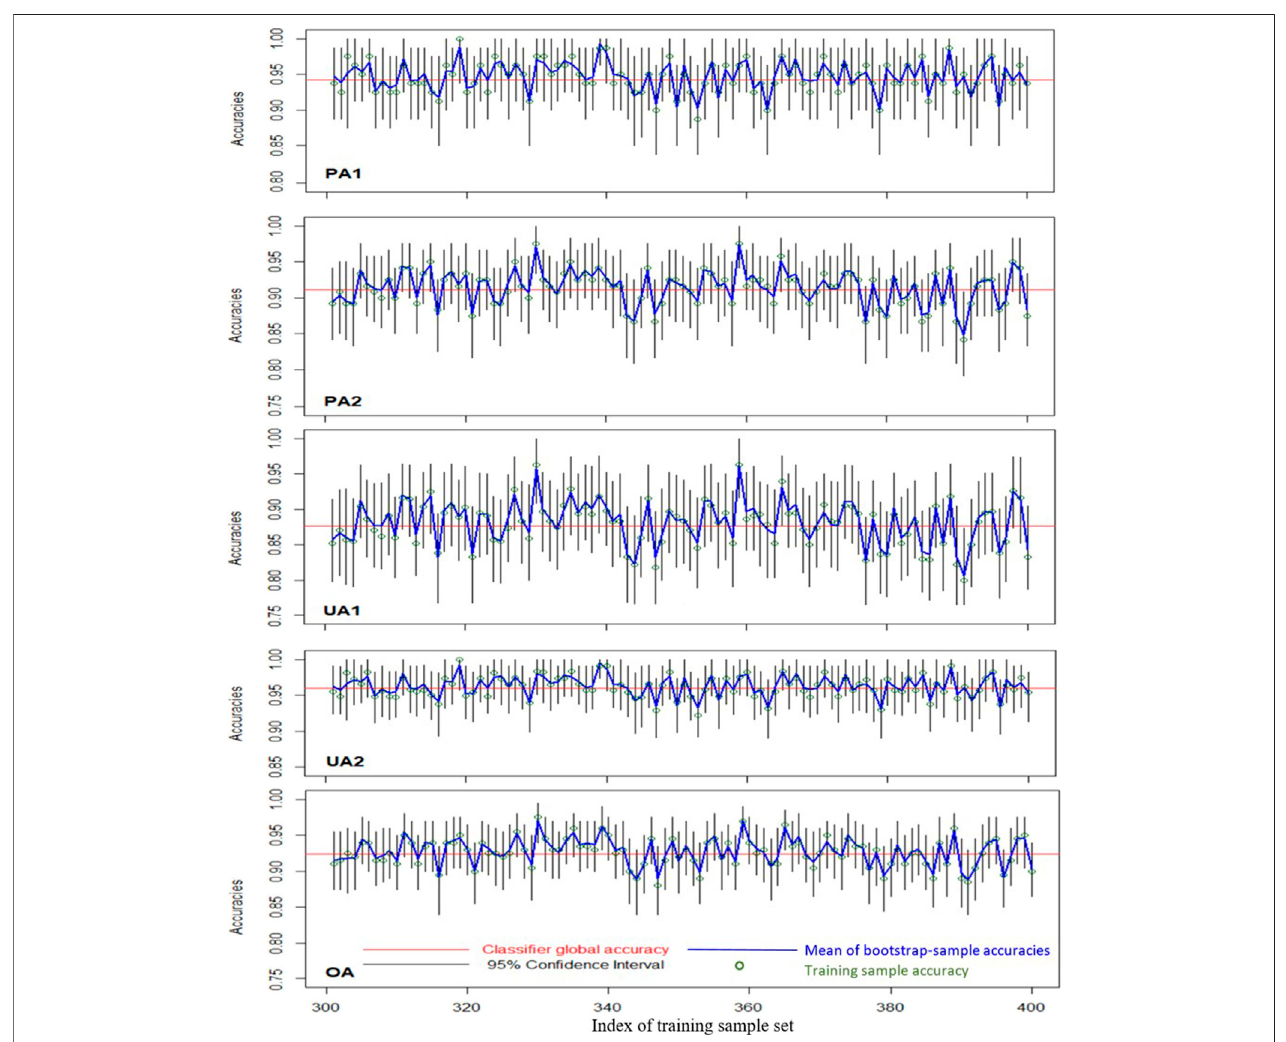
FIGURE 7 | Illustration of 95% bootstrap con fi dence intervals of different accuracy measures (2C2F case).